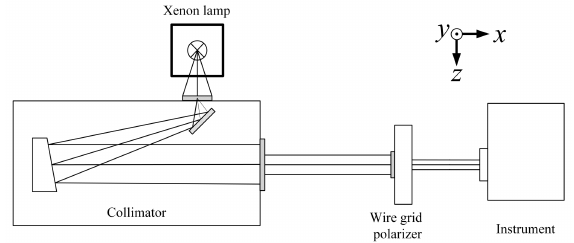
Figure 7. UV hyperspectral instrument’s polarization properties calibration device